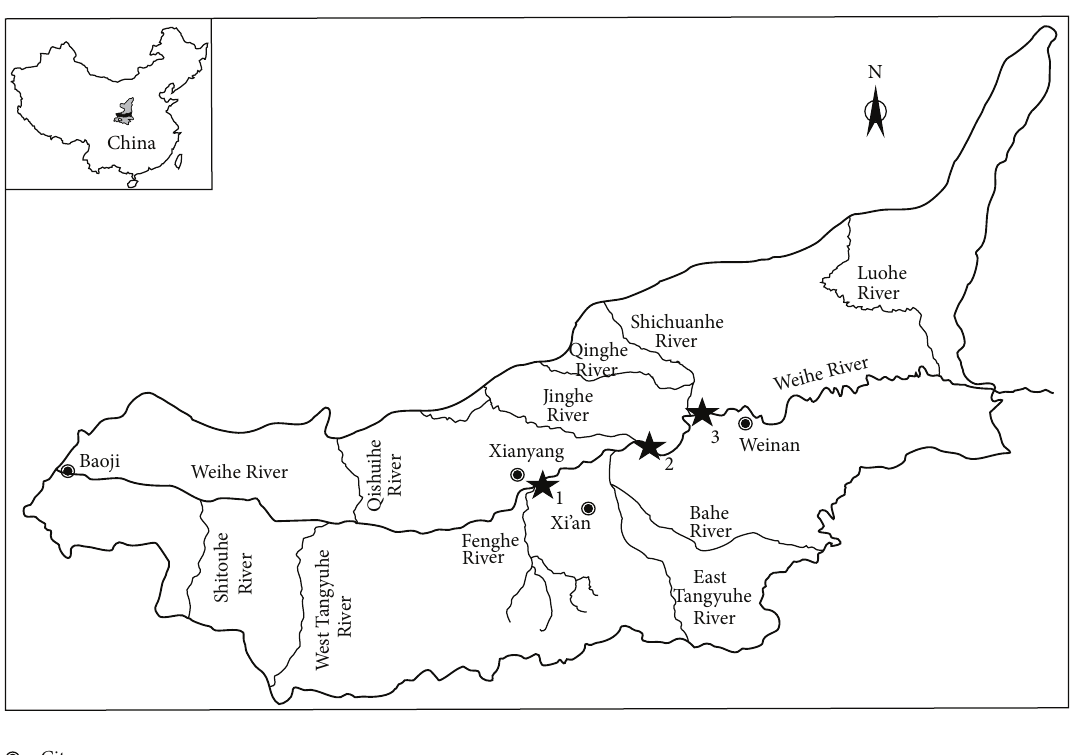
Figure 1: The sampling points of sediment in different